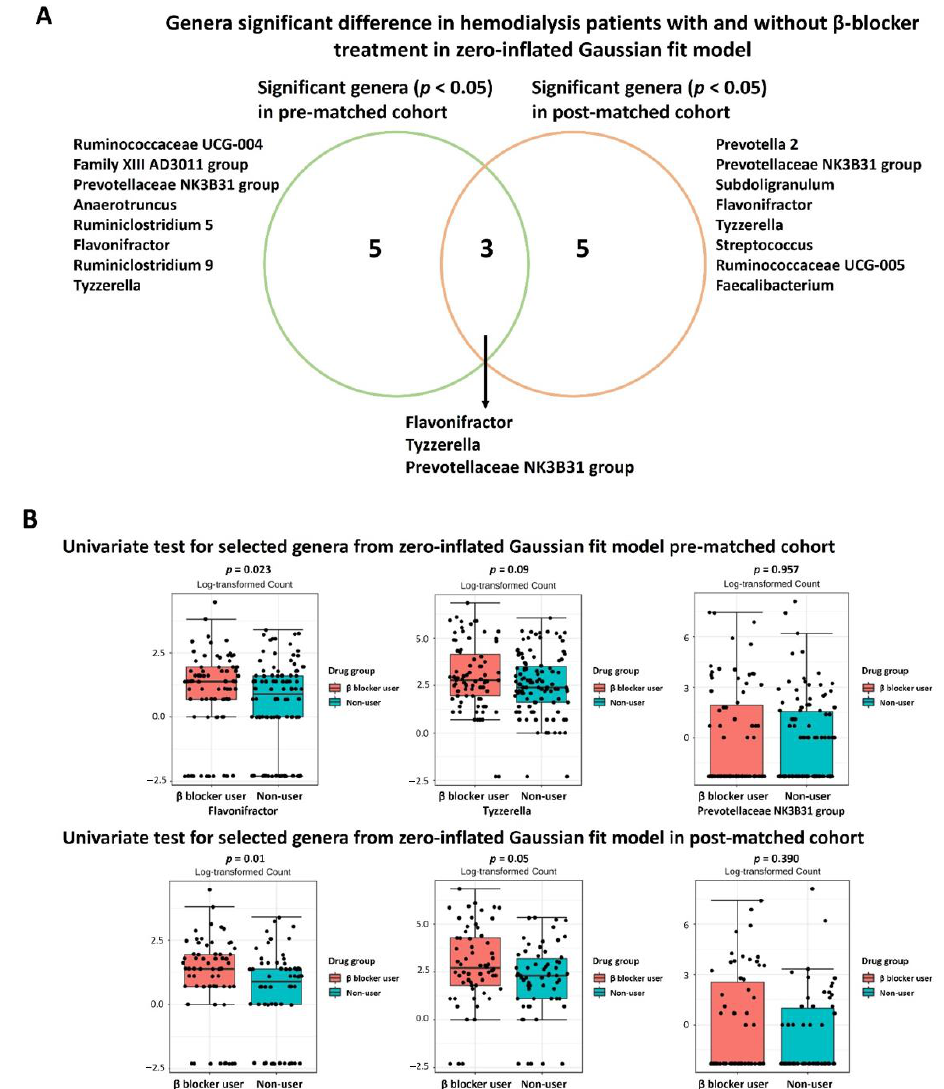
Figure 5 Figure 5. The genera difference between β blocker users and nonusers in the full cohort and propensity score matching cohort using zero-inflated Gaussian fit model. ( A ) The Venn diagram showed the different significant genera in the full cohort and propensity score-matched cohort. ( B ) Univariate test between selected genera from zero-inflated Gaussian fit model. Significance was considered for p <